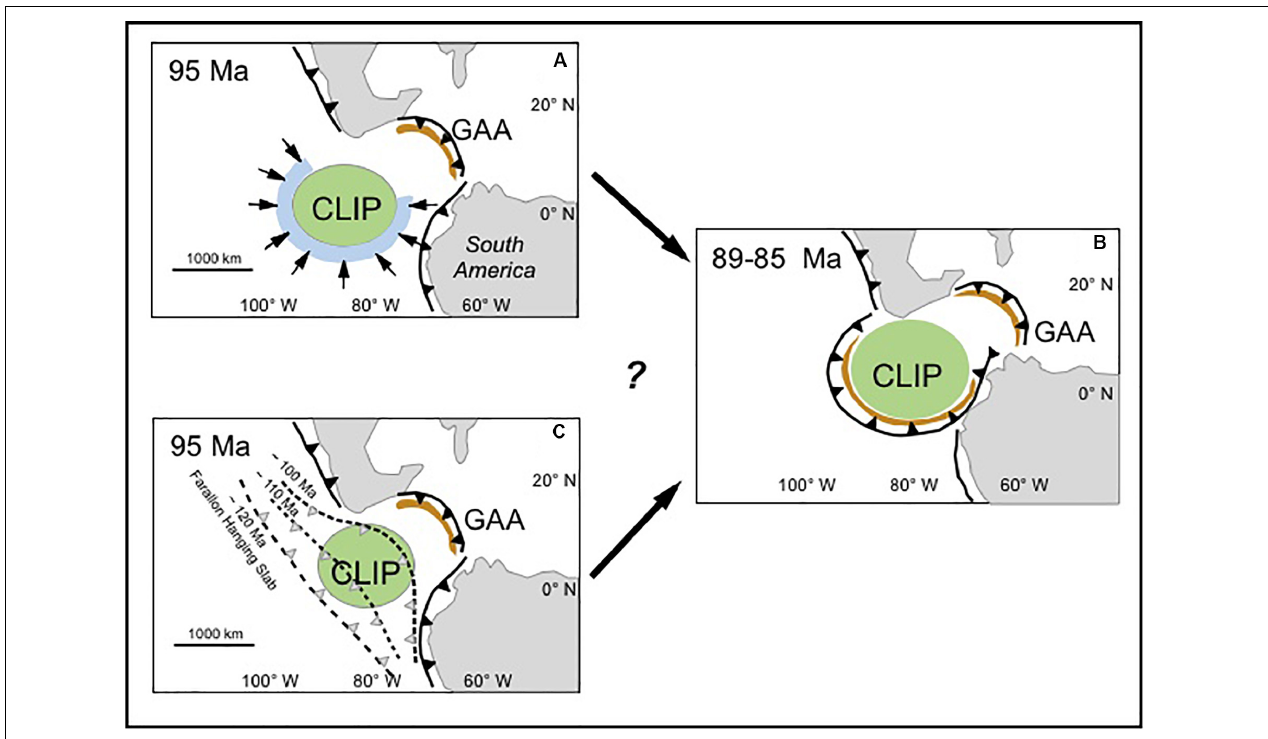
FIGURE 9 | An MTZ – damp komatiite alternative model for the Caribbean Large Igneous Province. (A,B) Two panels for the plume-initiated subduction CLIP model of Whattam and Stern (2015), which invokes a deep mantle plume (likely the Galapagos Hot Spot) as the focus point of subduction initiation. The blue area in (A) is the site of slab sinking and subduction initiation around the early CLIP, following the model of Ueda et al. (2008). Brown areas in all panels are regions of active oceanic arc construction. (C) An endmember alternative model for an MTZ origin for the entire CLIP, based on evidence against a role for the Galapagos Hot Spot and the “coincidental” site of the CLIP in proximity to east- and west-dipping subduction zones at the gap between North and South America. (C) Shows the inferred location of the subducting Farallon slab just before polarity reversal and the location of the trench of the west-dipping subduction at 110 and 100 Ma (Pindell et al., 2006). The ∼ 120 Ma Farallon initially represents an east-dipping hanging slab in the mantle as west-dipping slab of the Greater Antilles Arc (GAA) retreats, prompting the initiation of an MTZ damp plume. By 89–85 Ma, the regional slab configurations match those proposed by Whattam and Stern (2015) and define a “bowl” of inward-facing subduction that maintains a “big wedge” CLIP